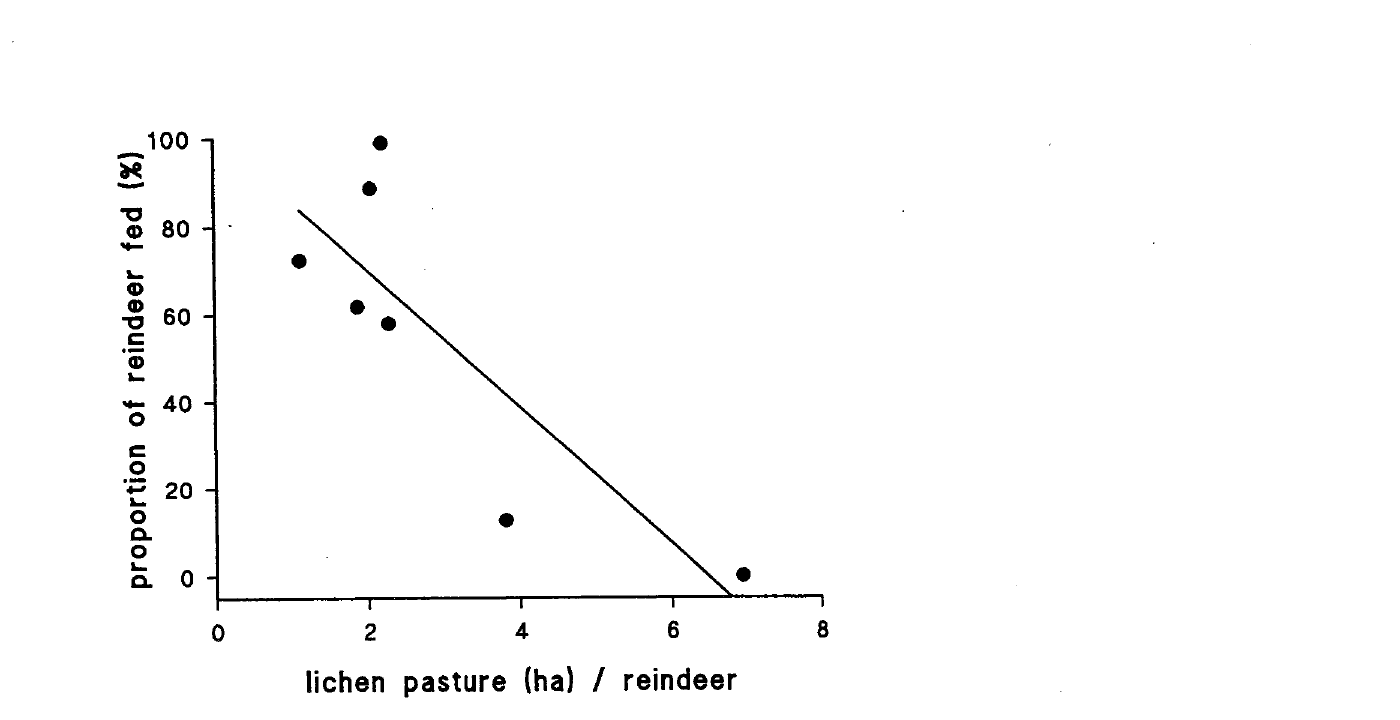
Figure 2. The dependence between the available lichen pasture area (ha / reindeer) and the proportion of reindeer fed (%) in all the districts (R2=71, P=0.02, N=7).